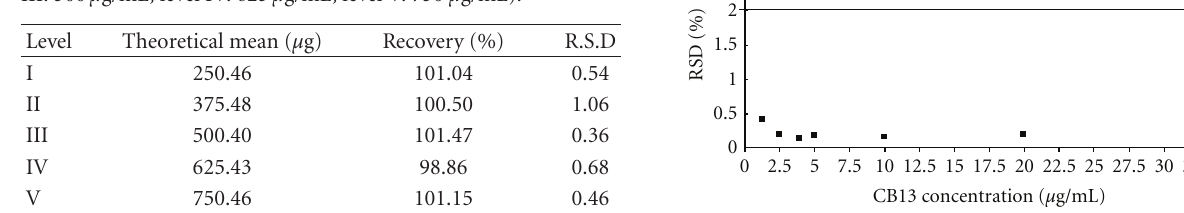
Table 1: Results of recovery (%) and RSD (%) for CB13 from stan- dard solutions ( n = 6) (level I: 250 µ g/mL; level II: 375 µ g/mL; level